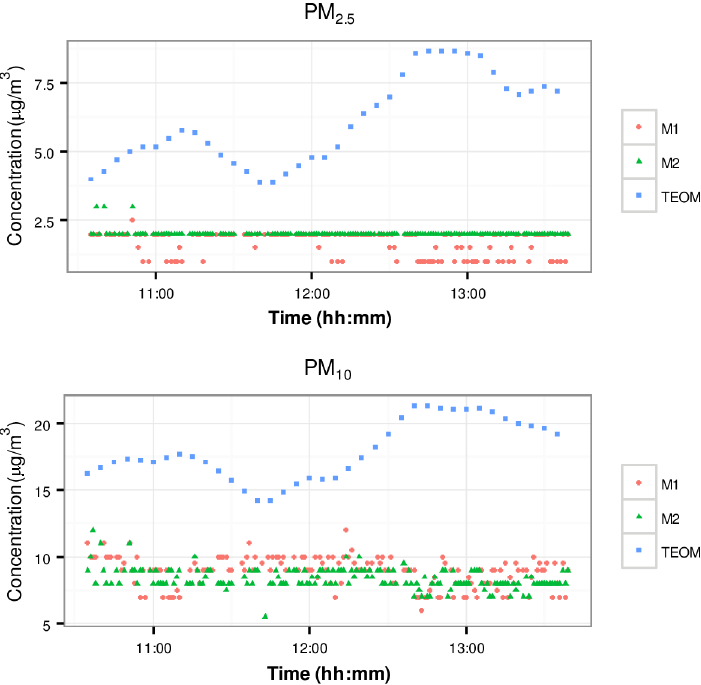
Fig 6. Time series of mass concentrations at the Rocklea station measured by the phones and the